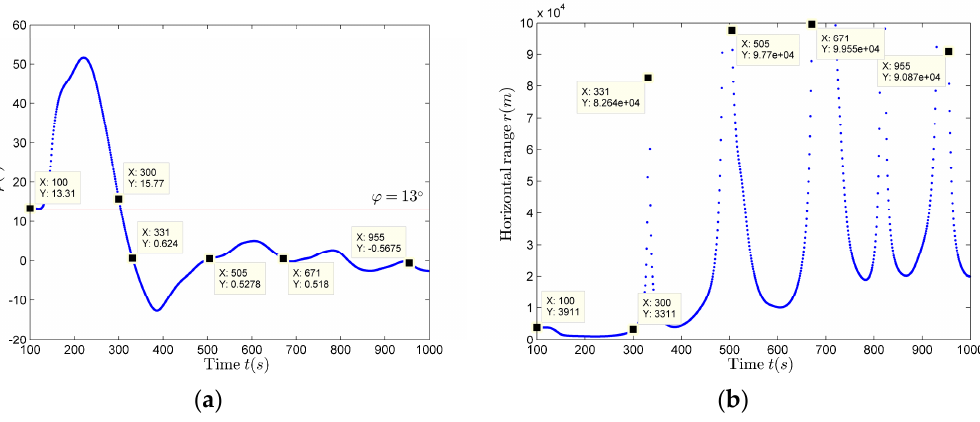
Figure 18. The horizontal distance Estimation Results if p = 900 m. ( a ) ϕ estimation results; ( b ) Horizontal distance estimation results.